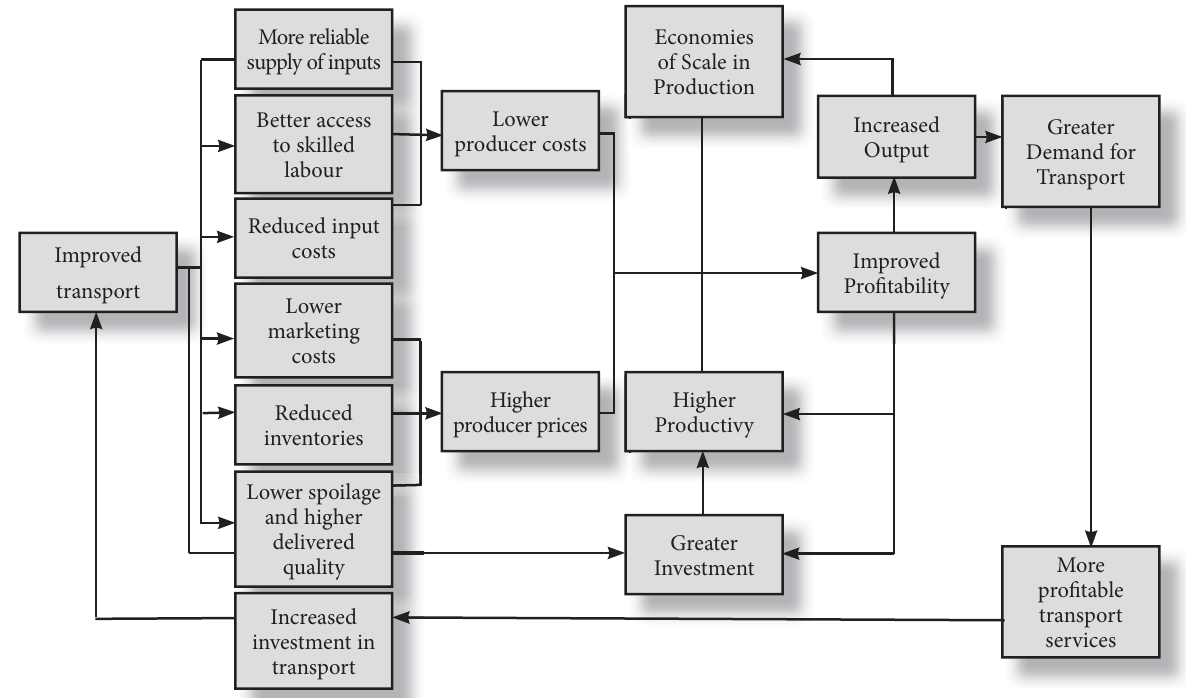
Fig. 3. Economic importance of transportation